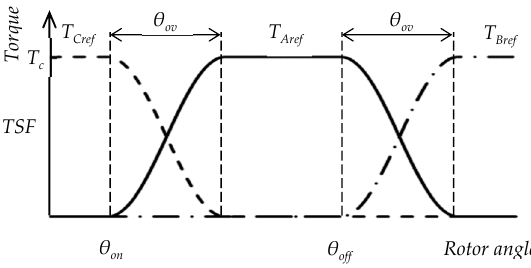
Figure 4. Sinusoidal torque sharing function.